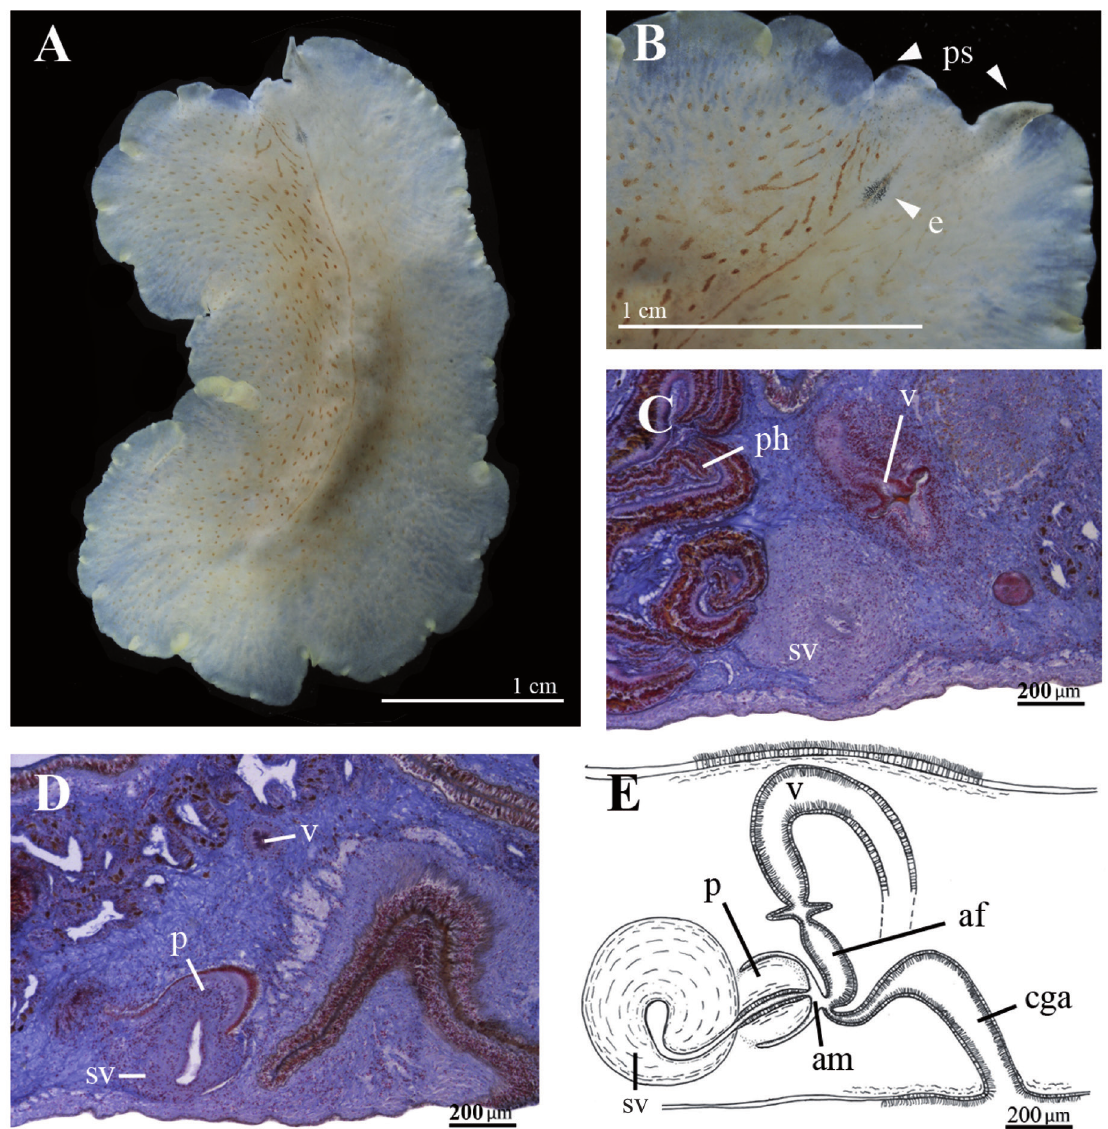
Fig. 2. Marcusia alba sp. nov. (MNCN 4.01/2620 to 2683). A . Whole live animal, dorsal view. B . Anterior region with cerebral eyes cluster and pseudotentacles (white arrows). C . Histological section of the male copulatory organ stained with AZAN. D . Histological section of the female copulatory organ stained with AZAN. E . Sagittal reconstruction of the reproduction system. Abbreviations: see Material and